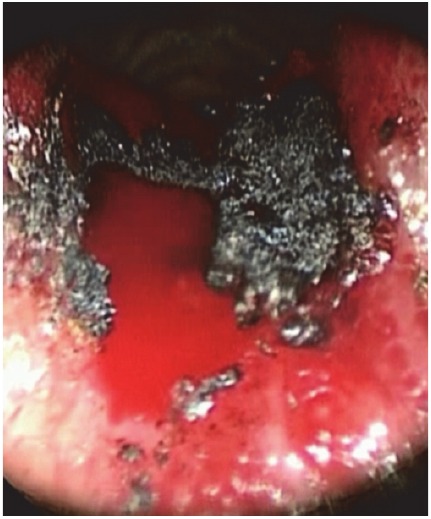
Figure 1: Intraoperative telescopic appearance of the subglottic tumor. Figure 2: Telescopic appearance of the underlying tissues following transoral laser resection of the remnant subglottic tumor.